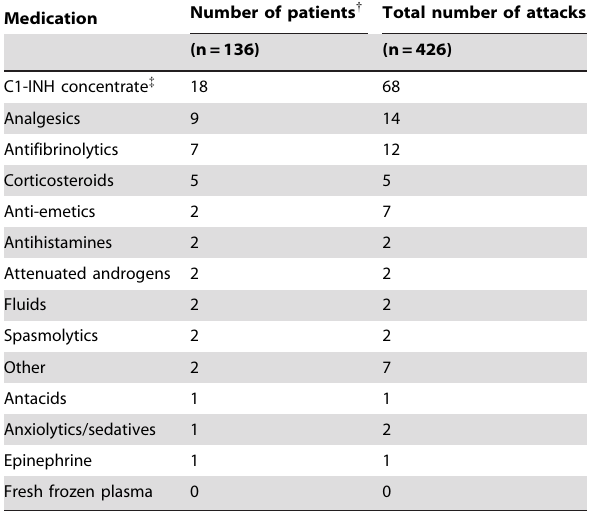
Table 2. Concomitant and/or rescue medication taken by the patient for the